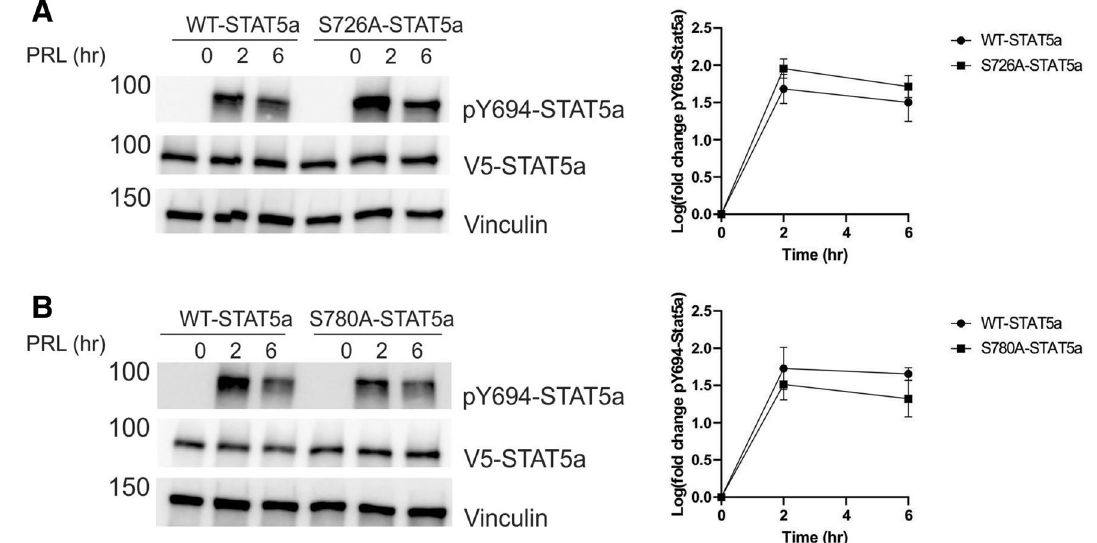
Figure 5. Induction of phosphorylation on residue Y694 is independent of either S726 or S780. MCF7 cells with stable re-expression of either WT-STAT5a, S726A-STAT5a ( A ), or S780A-STAT5a ( B ) were treated with PRL up to 6 h. Representative blots of 3 independent experiments for pY694-STAT5a induction shown, with quantification by densitometric analysis performed in GraphPad Prism 9.0.0 for Windows (GraphPad Software, San Diego, California USA, www. graph pad.